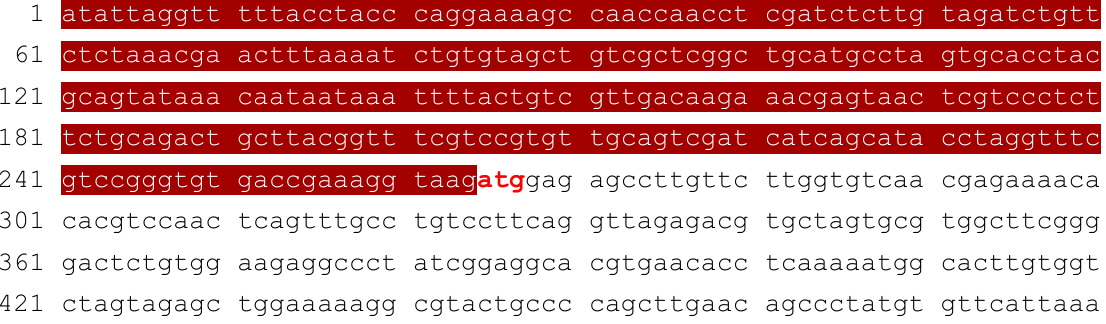
Figure 2. Comparative analysis of the 5’UTR of the pp1a gene sequence